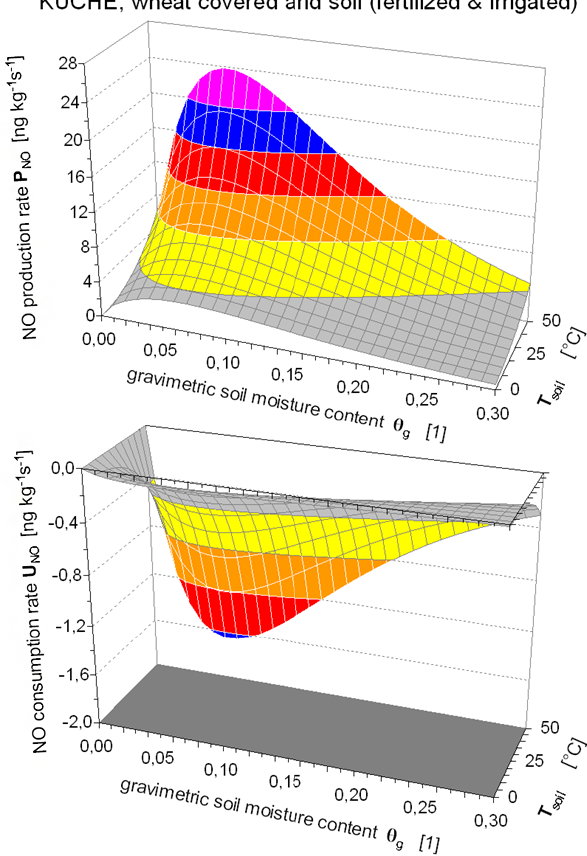
Figure 23. Two-dimensional illustration of NO production rate P NO (θ g , T soil ) and NO consumption rate U NO (θ g , T soil ) for the KUCHE wheat soil. Data have been calculated using P NO (θ 0 , T 0 ), k NO (θ 0 , T 0 ), Q 10_P , NO , and Q 10_U , NO data listed in Table 2. of θ 0 (0.027) and θ g,1 (0.10) at T soil = 20 ◦ C as well as